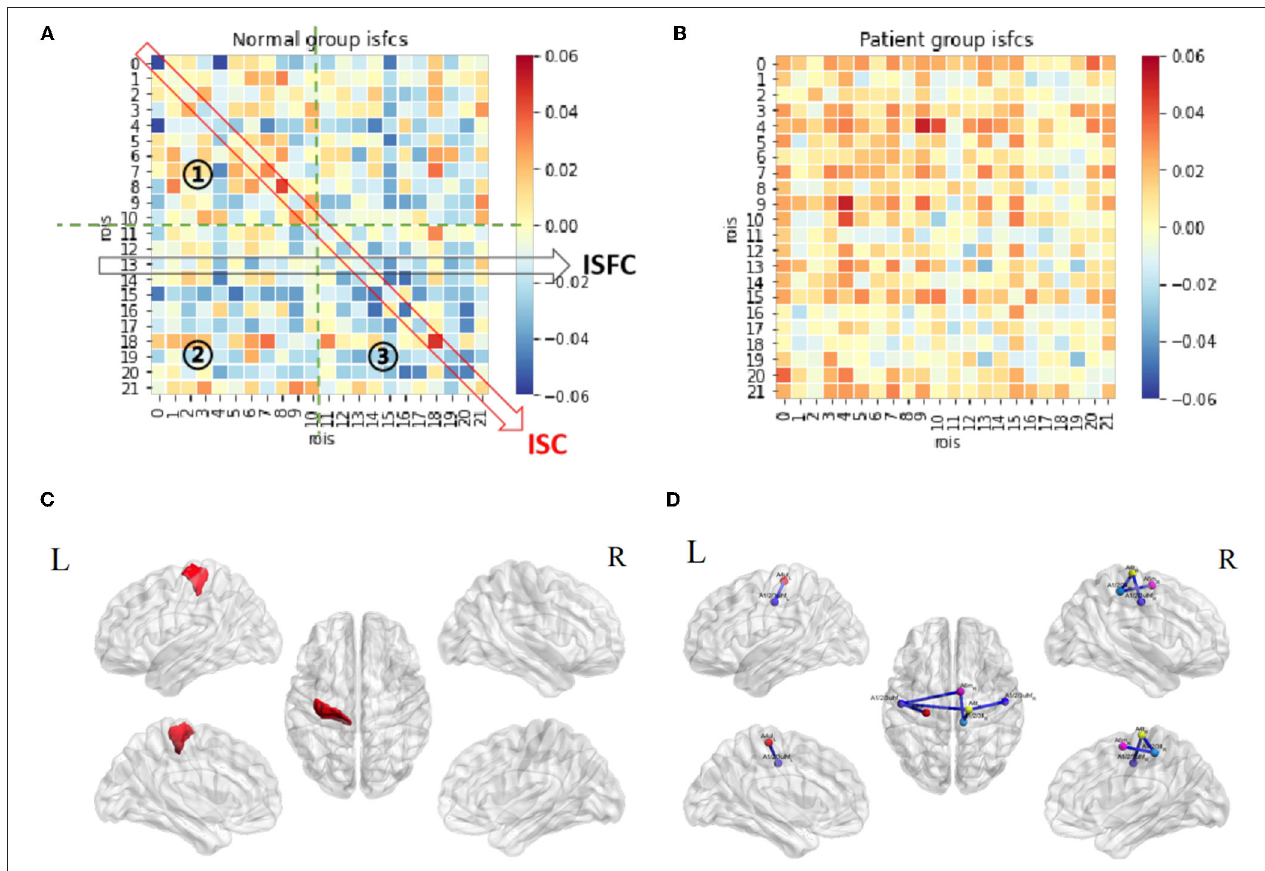
FIGURE 4 | Resting-state ISC and ISFC. (A) The ISFC matrix of 22 ROIs during resting state in the control group. The off-diagonal values represent intersubject functional correlations between ROIs, while the diagonal values represent intersubject correlation within each ROI. ‹ , › , and fi represent the area of contralesional hemisphere, between hemispheres, and ipsilesional hemisphere (the other matrices in this article follow this law). (B) ISFC matrix of 22 ROIs during resting state in the patient group. (C) Significant ROI at resting-state in the control group ( p < 0.05, FDR-corrected). (D) Significant negative ISFCs (lines in blue) between ROIs in the control group ( p < 0.05,